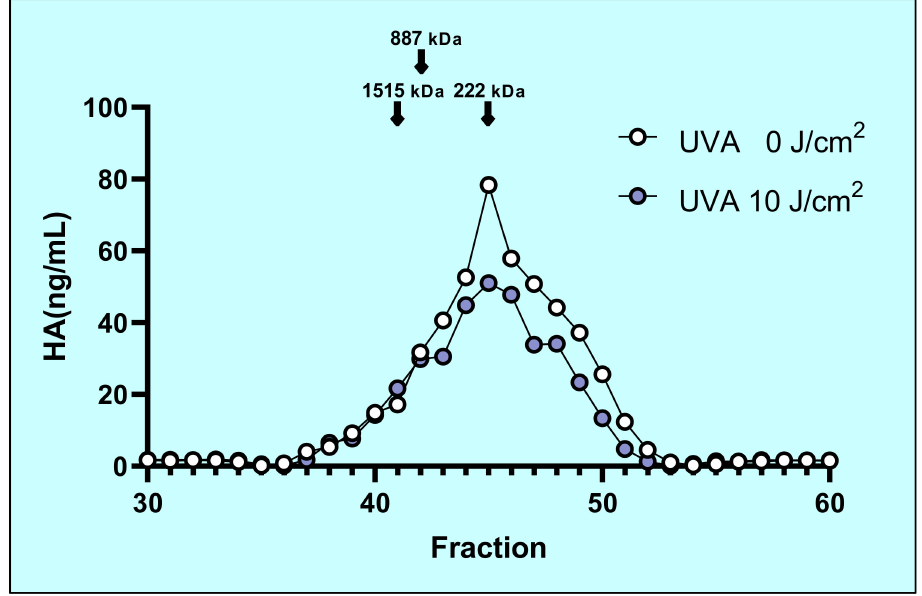
Figure 3. Changes of the molecular mass of HA after UVA irradiation. HA was extracted from the conditioned medium in non- (white circle) or UVA-irradiated (black circle) HFs at 48 h post- irradiation and applied to a Shodex OHpak SB-807 HQ column, and the HA concentration was measured by the Hyaluronan Binding Protein (HABP). sandwich assay. Each graph compares the non-UVA-irradiated molecular mass distribution with UVA-irradiated molecular mass